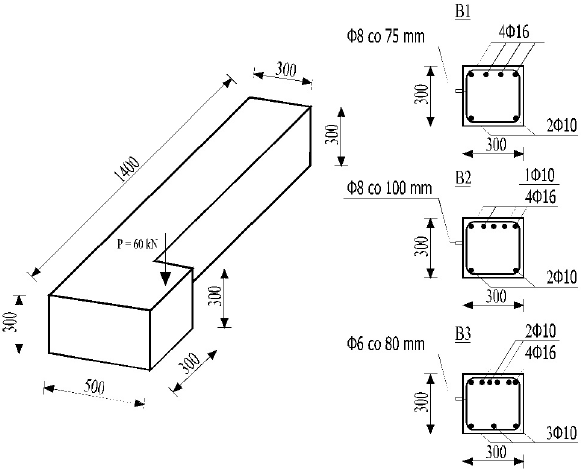
Figure 4: Geometry and reinforcement of the analysed beams